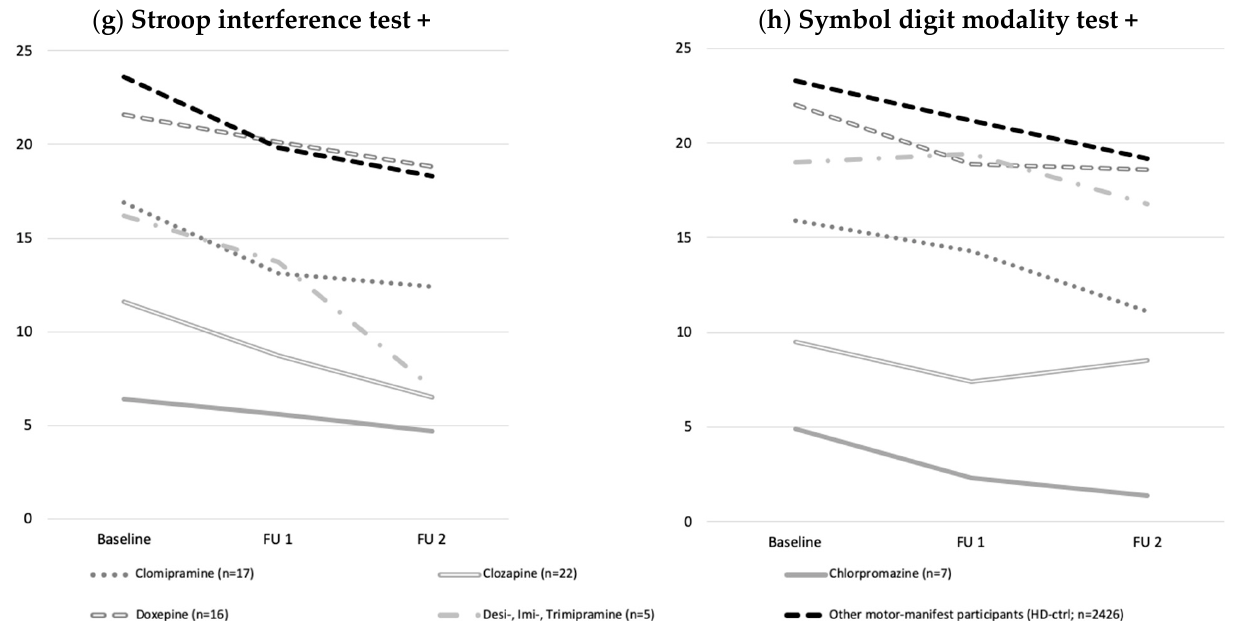
Figure 2. Development of motoric, functional and cognitive performance over two years. ( a ) Motor (UHDRS TMS), ( b , c ) functional, ( d – h ) and cognitive performance declined over time without effect of medication taken compared to HD-ctrl. Data were analyzed using ANOVAs with co-variates (age, CAG) for baseline, follow up one and two, comparing respective medication- and HD-ctrl over time. Abbreviations: UHDRS: Unified Huntington’s Disease Rating Scale; FU1: Follow up one; FU2: Follow up two; #: higher scores= more impairment; +: higher scores= better performance.